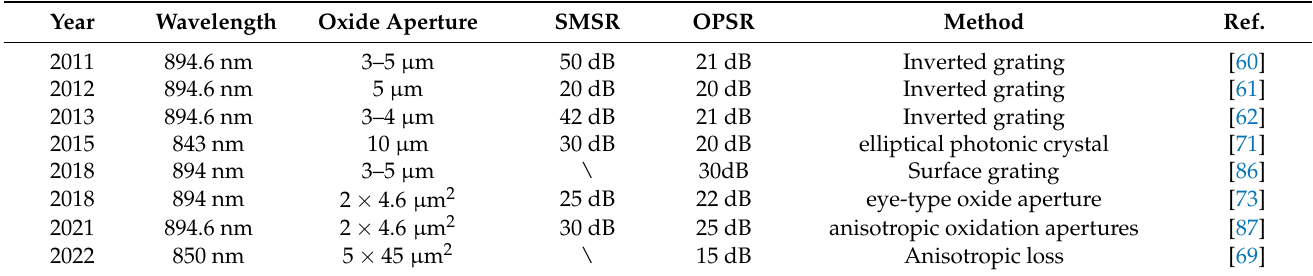
Table 2. Research progress of the single-polarization control method of